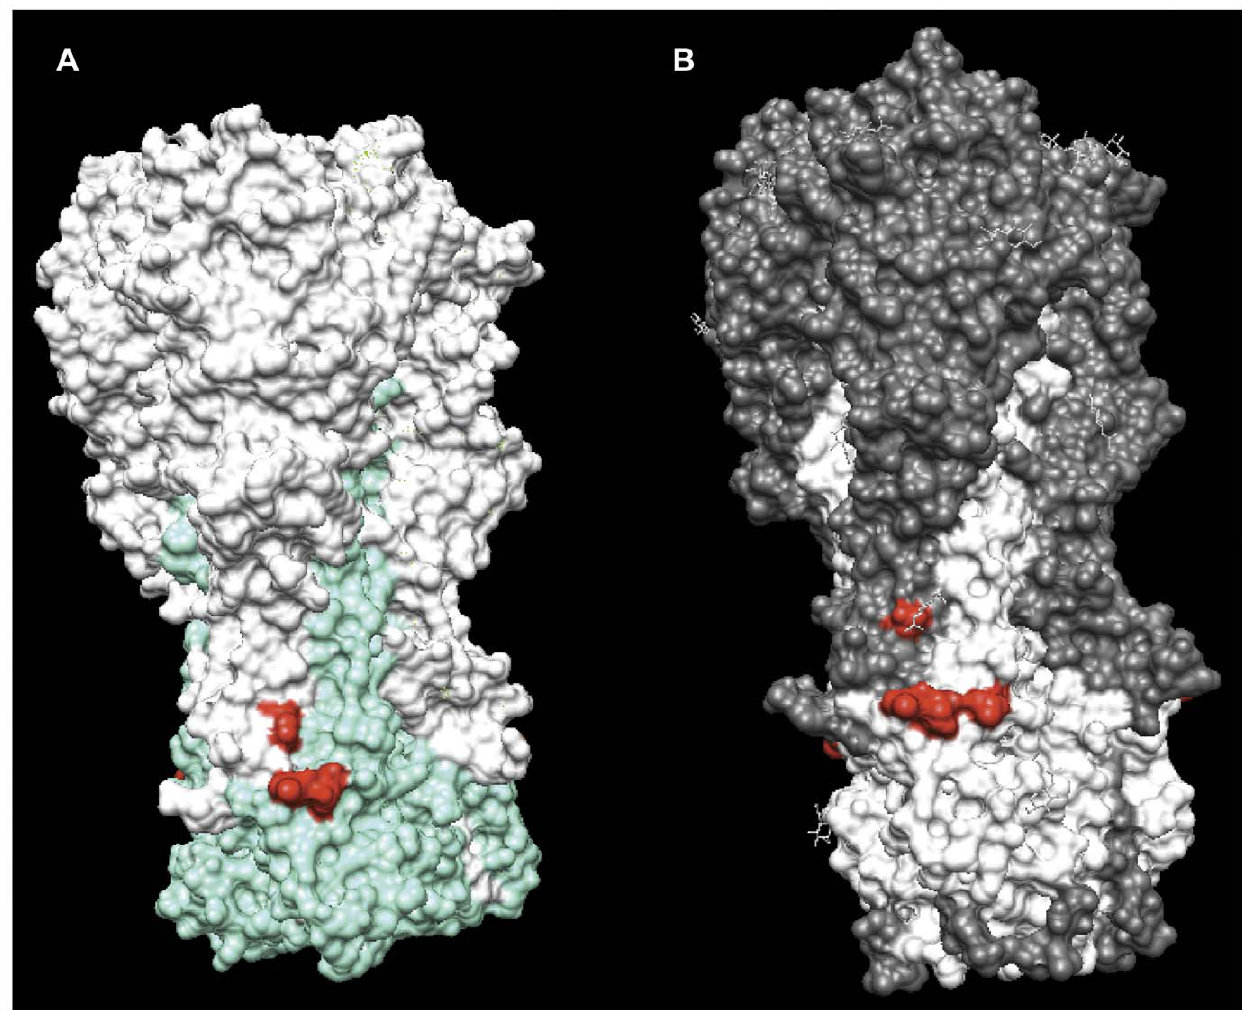
Figure 4. Comparison of the core of PN-SIA28 epitope on the surface of H1 and H3 trimers. (A) (H1N1) A/PR/8/34 HA: white areas indicate the HA1 domains of H1 trimer whereas cyan areas indicate its HA2 domains. (B) (H3N2) A/Aichi/2/68 hemagglutinin: grey areas indicate the HA1 domains of H3 trimer whereas white areas indicate its HA2 domains. On both pictures, red regions indicate the residues 25 and 45 on HA1 and residues 361 and 362 on HA2 that, when mutated, were able to inhibit PN-SIA28 binding both to H1 and H3 HAs.